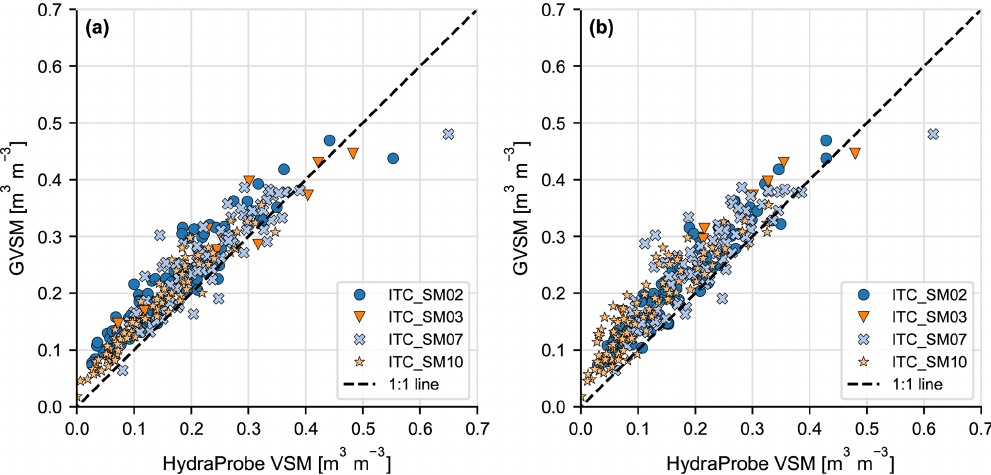
Figure 7. Scatterplots with the HydraProbe VSM against the GVSM collected during the 2016 and 2017 field campaigns. In subplot (a) is the HydraProbe VSM reading taken next to the GVSM measurement. In subplot (b) is the mean of the HydraProbe VSM readings matched